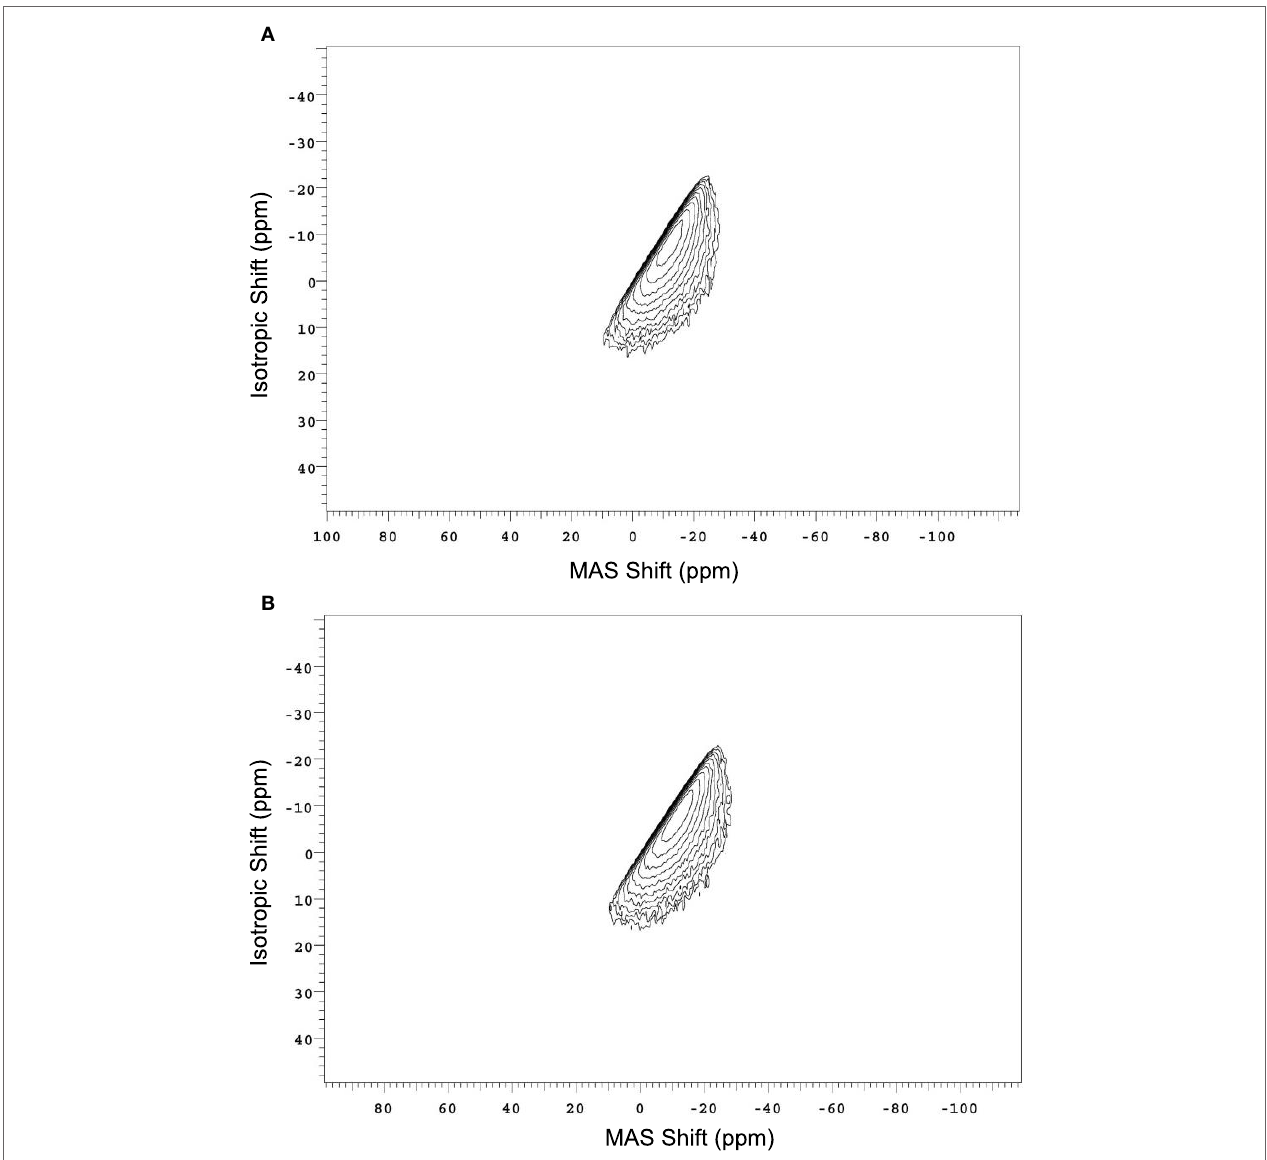
FigUre 14 | 23 na 3QMas nMr spectra of the aluminosilicate glass (a) annealed for 168 h at 0.92 T g and (B) compressed at 1 gPa and 650°c after ion exchange at 410°c . Peak positions in the two dimensions are used to calculate δ CS and P q , as described in the